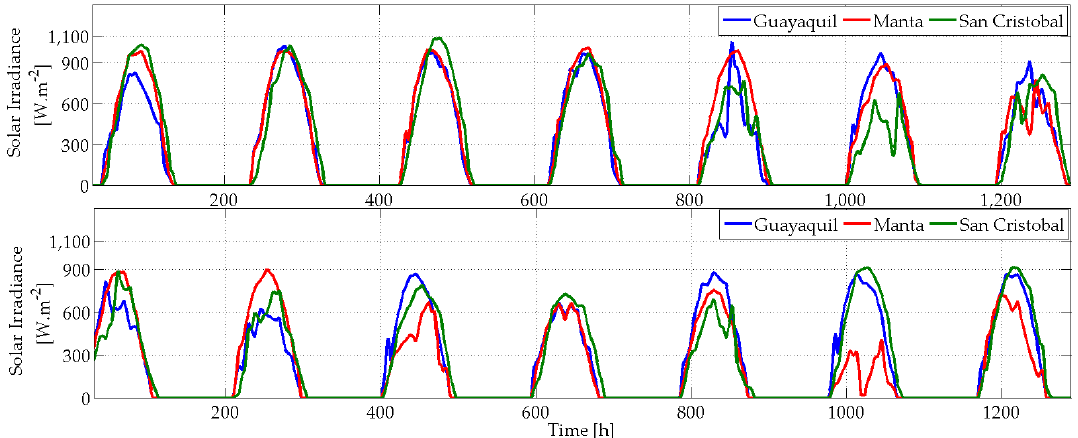
Figure 11. Solar irradiance in three selected sites of Ecuador from 8–14 February and 13–19 July.